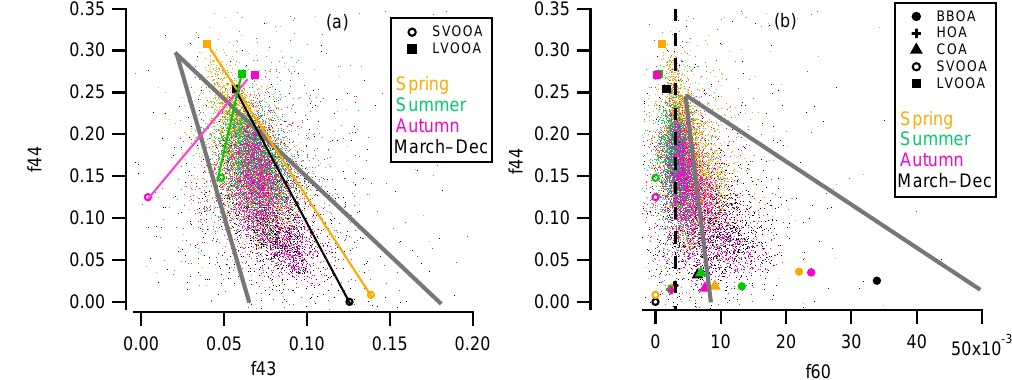
Figure 4. (a) f 44 vs. f 43 and (b) f 44 vs. f 60 plots for different periods of time.